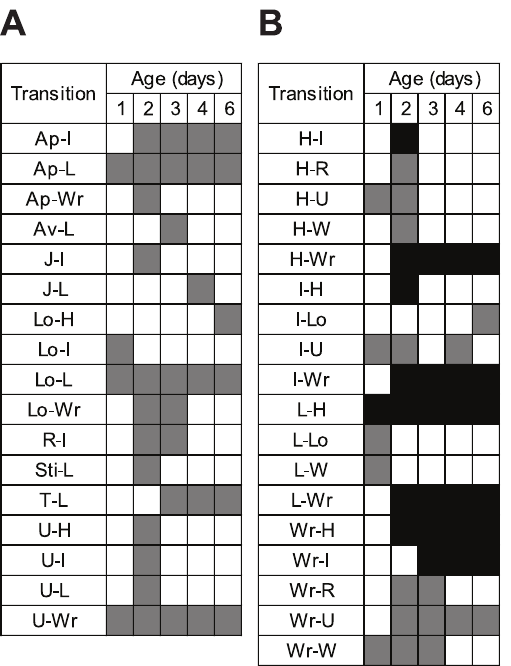
Figure 11. Behavioral transitions involving high-intensity aggressive behaviors by age. All transitions are depicted as first behavior followed by the second. (A) Transitions to high-intensity aggressive behaviors from other behaviors. (B) Transitions from high- intensity behaviors to other behaviors. Gray cells indicate the presence of significant transitions in which only one of the behaviors is a high- intensity aggressive behavior. Black cells indicate significant transitions in which both behaviors are high-intensity aggressive.